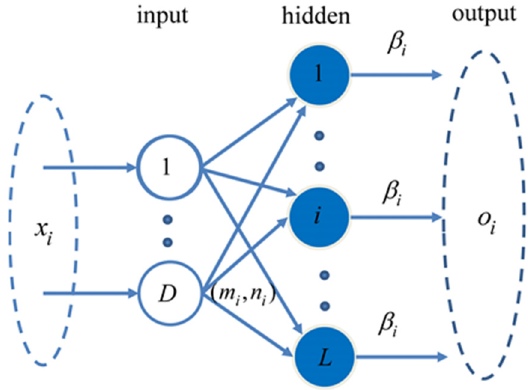
Figure 2. Flowchart of the ELM architecture.